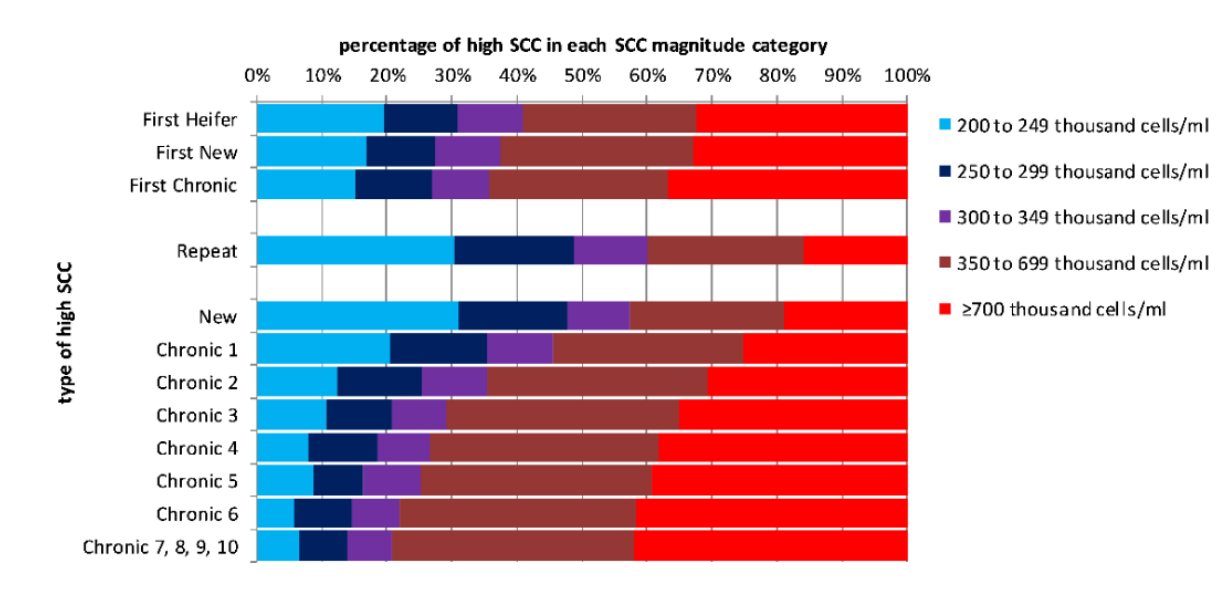
Figure 1: Distribution of high SCC MRs between SCC magnitude categories for the different categories of high SCC Although the ‘New’ high SCC MRs and the ‘Repeat’ high SCC have a similar profile (over 30% have a value of <250 thousand cells/ml and almost 50% are <300 thousand cells/ml) (Fig. 1) the proportion of cows